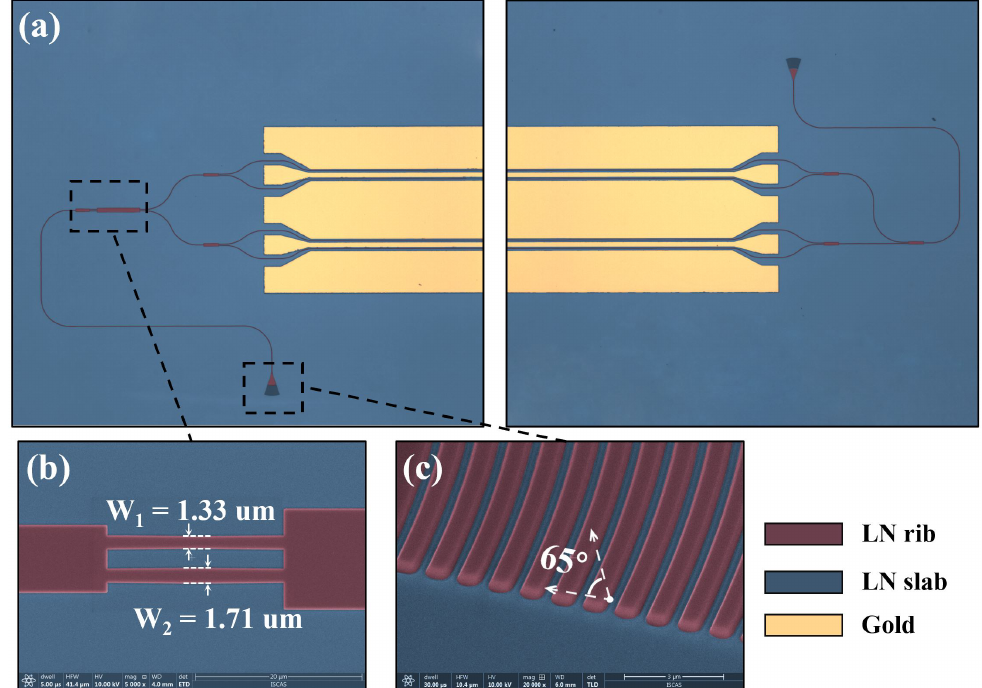
Figure 3. ( a ) False-color scanning electron microscope (SEM) image of the demonstrated DP-MZM. ( b ) Close-up of the passive phase shifters. The line widths were measured at the upper surface of the waveguide. ( c ) Close-up of the grating couplers from a 52-degree